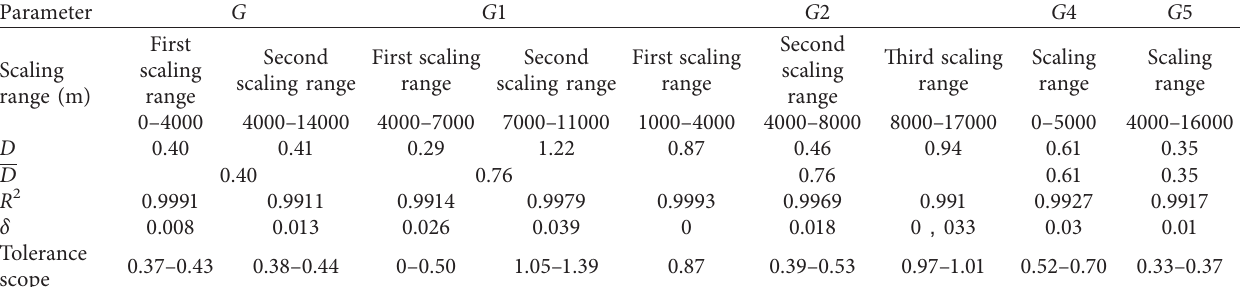
Table 4: Scale areas, fractal dimension results, and confidence statements of various types of green land calculated by using the radius